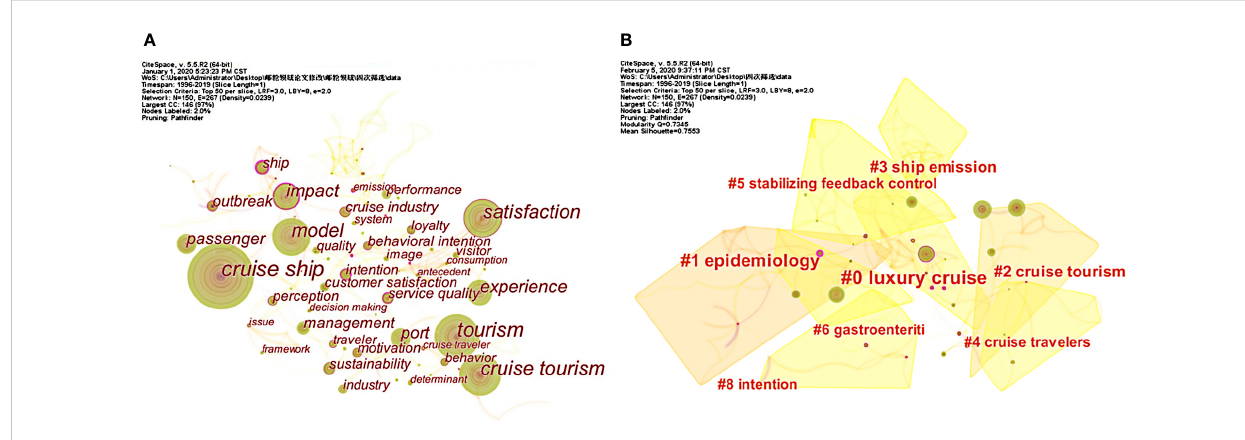
FIGURE 7 A visual map of keywords in cruise research: (A) the main keywords in cruise research; (B) the cluster map of keywords.